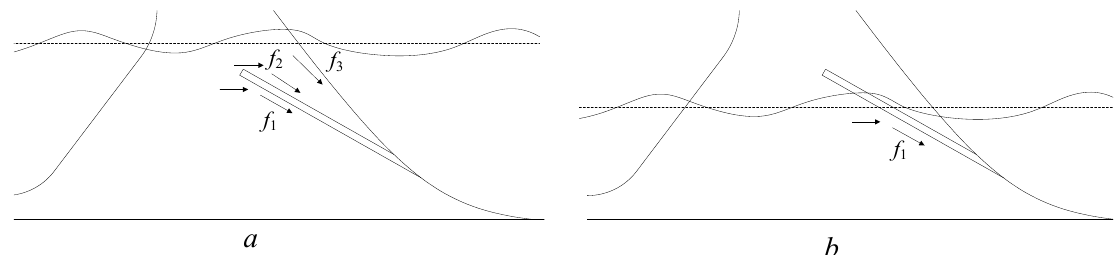
Figure 1. Diagram of friction at Flanks and concave groove. ( a ) Flanks are underwater; ( b ) Flanks expose the free surface.